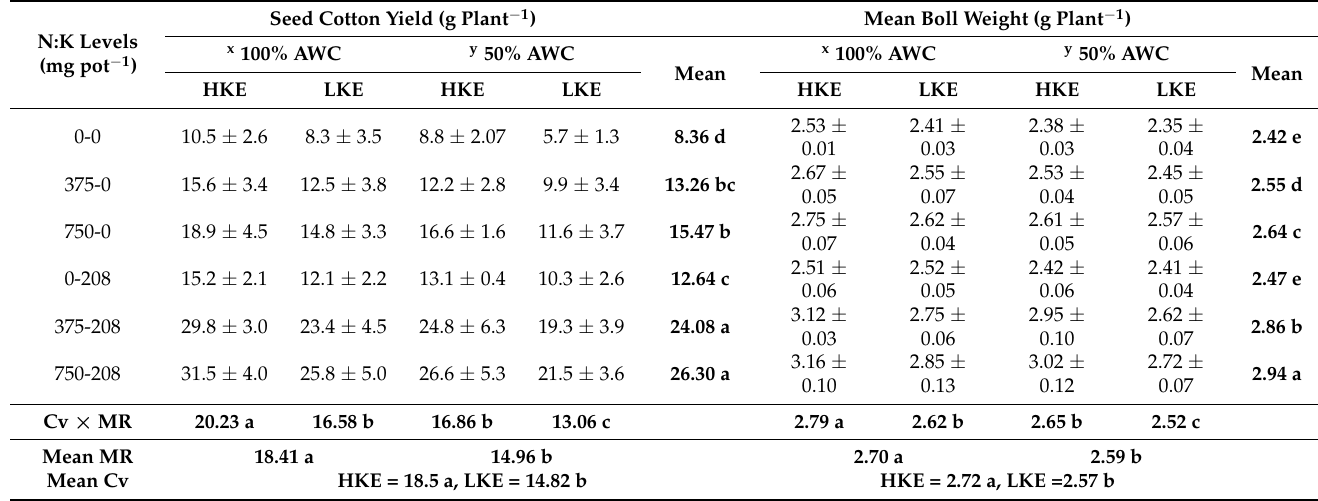
Table 3. Effect of applied N:K levels on seed cotton yield and mean boll weight of HKE and LKE cultivars of cotton under varied irrigation